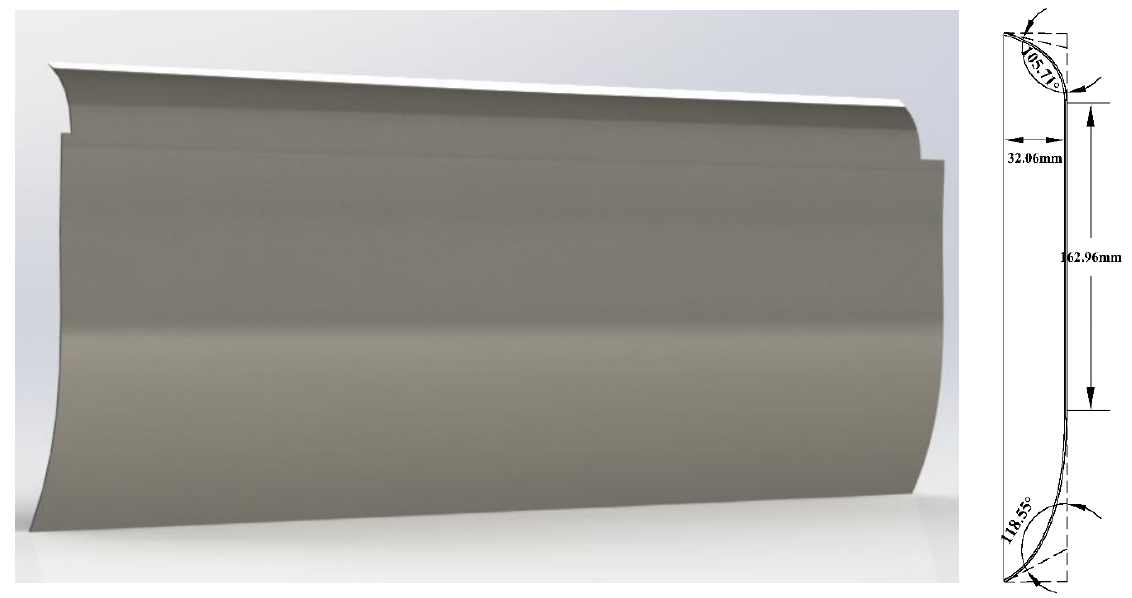
Table 4. Comparison of parameters before and after optimization.